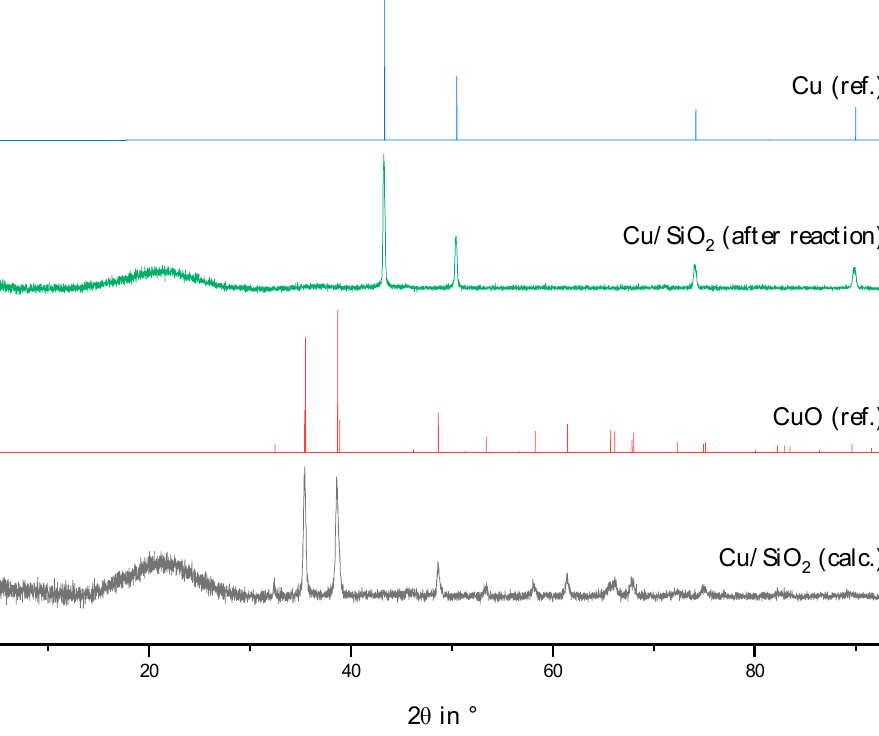
Figure A10. P-XRD of calcined silver catalyst before reaction (calc.) and after reaction.